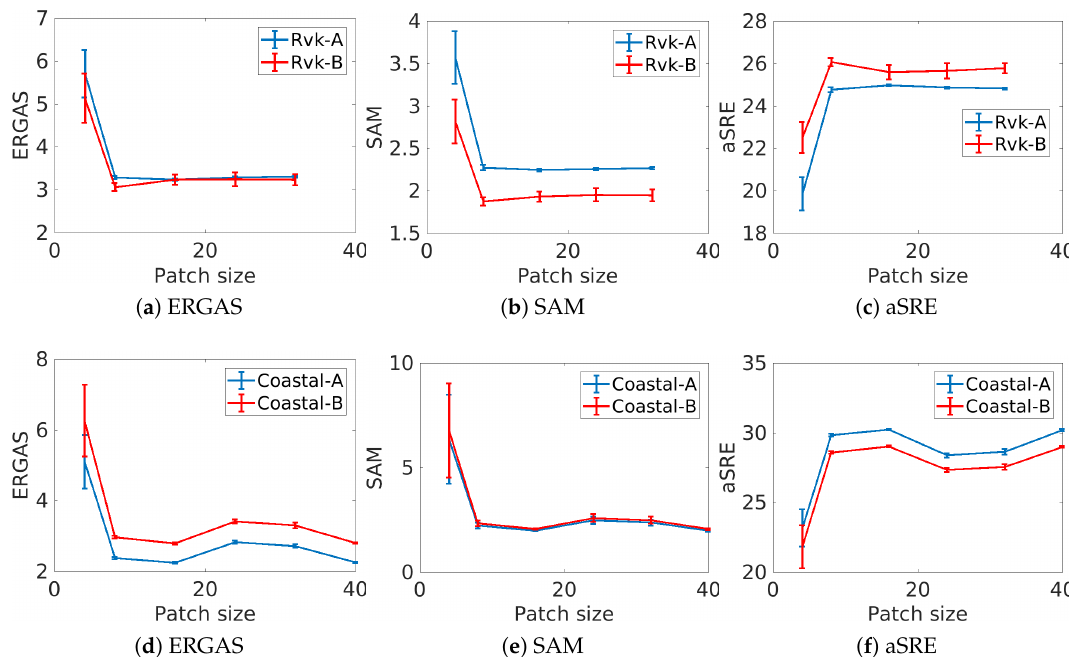
Figure 9. Values of the quality evaluation metrics as a function of the patch size for the Coastal and urban Rvk datasets. The network was trained on the A image and tested on A and B. aSRE is the average SRE of the bands and is given in dB and SAM is given in